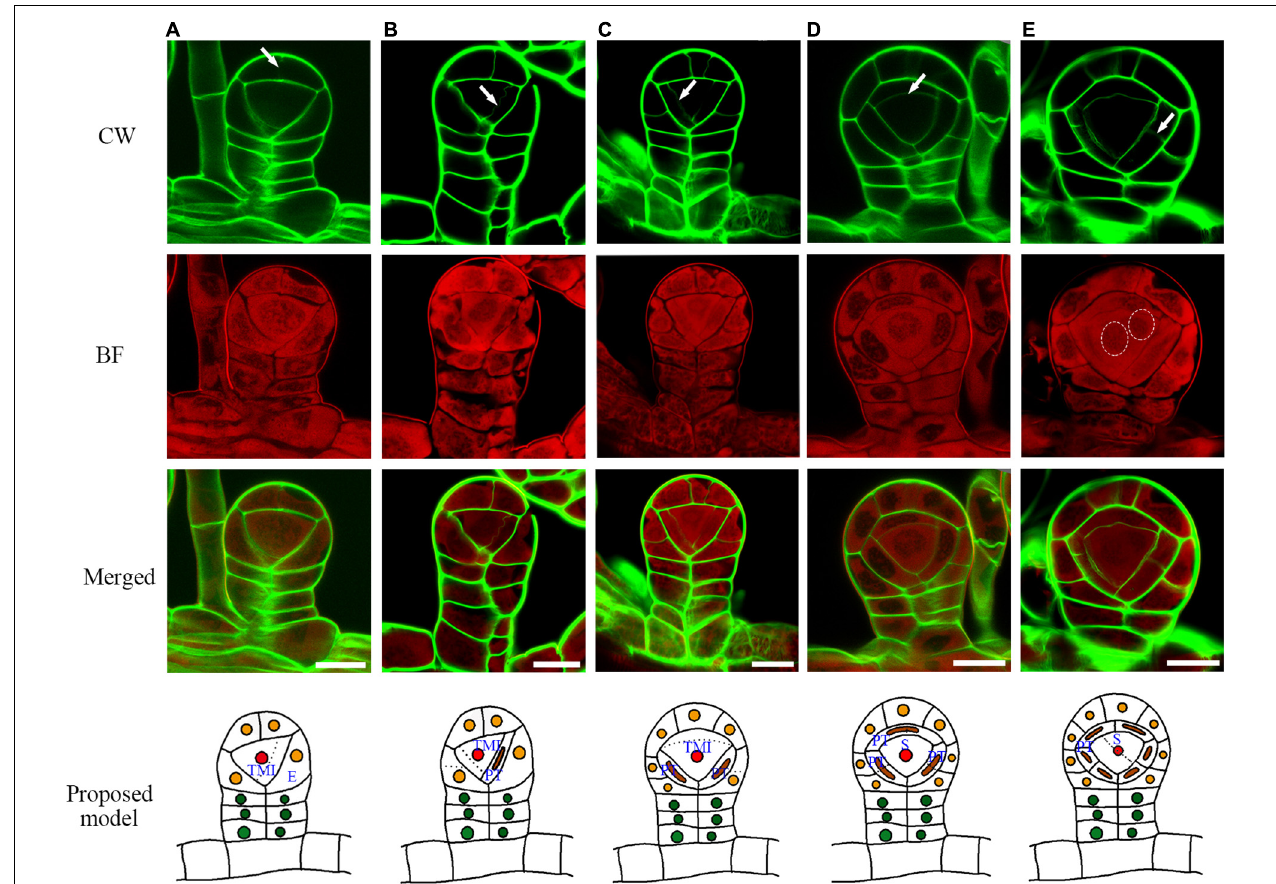
FIGURE 3 | The sporangium development with the formation of epidermis, tapetum, and sporangium cells. (A) The cap epidermis cell of the capsule undergoes an anticlinal division. (B) The tetrahedral mother initial cell cuts off the first primary tapetum cell. (C) The tetrahedral mother initial cell cuts off the second primary tapetum cell. (D) Arrow points to the cell wall being formed between the primary sporogenous cell and the primary tapetum cell. (E) The primary tapetum cell undergoes an anticlinal division. Two dotted circles point to the nuclear division. CW signals are colored green. BF signals are colored red. Arrow points to the newly formed cell wall. Scale bar = 20 µ m. (A–E) Proposed models are shown on the right of each inset. TMI, tetrahedral mother initial cell; PT, primary tapetum cell; S, sporogenous cell; E, epidermis cell.